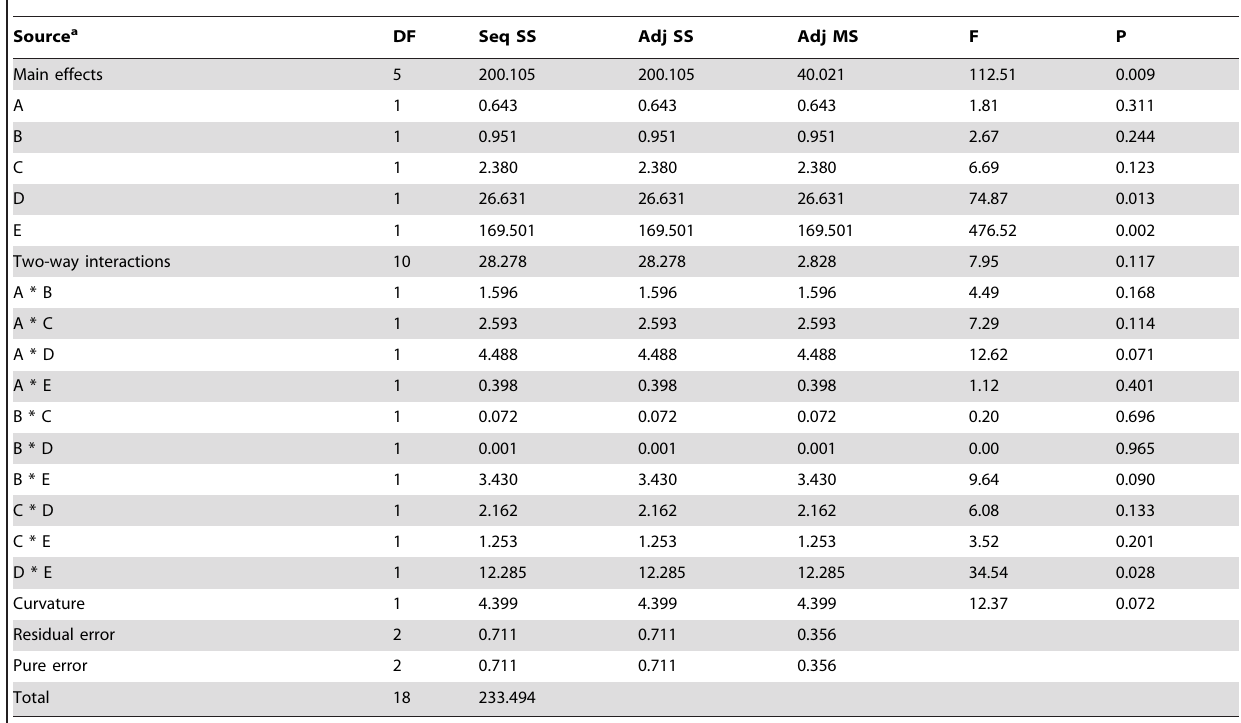
Table 3. Analysis of variance for